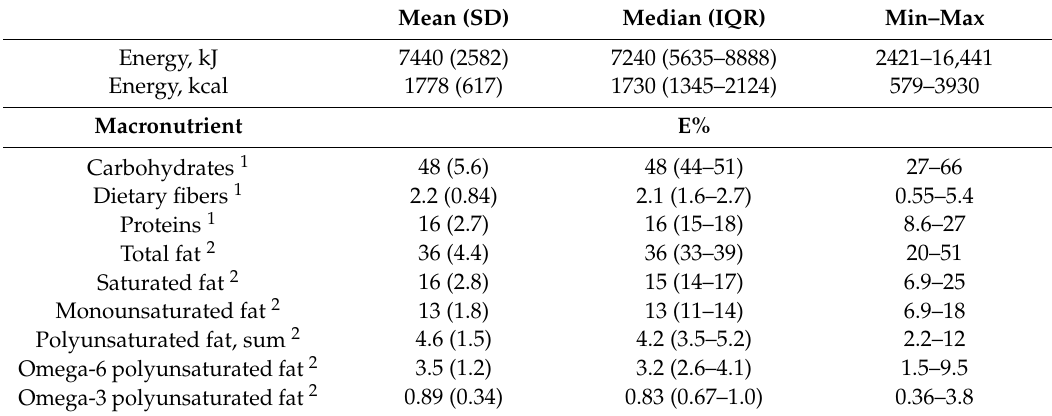
Table 3. Energy intake and intake of macronutrients, in energy percent (E%) ( N = 567).